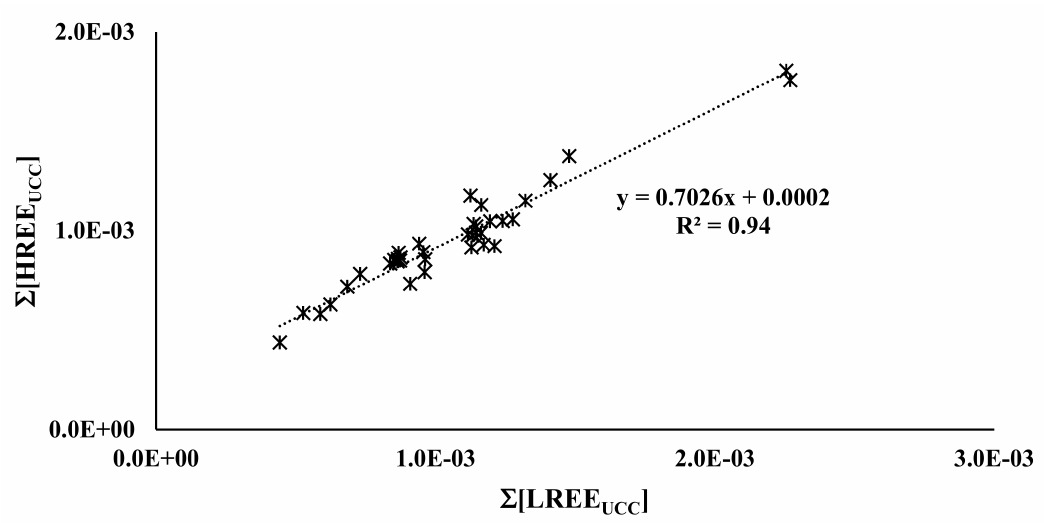
Figure 2. ∑ [HREE UCC ] vs. ∑ [LREE UCC ] relation for all Campo Carboj olive pulp samples.